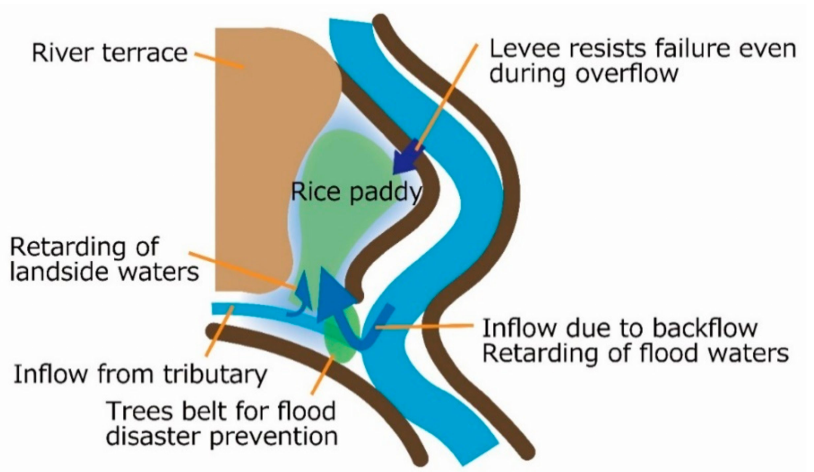
Figure 2. Open levee on flood plain.